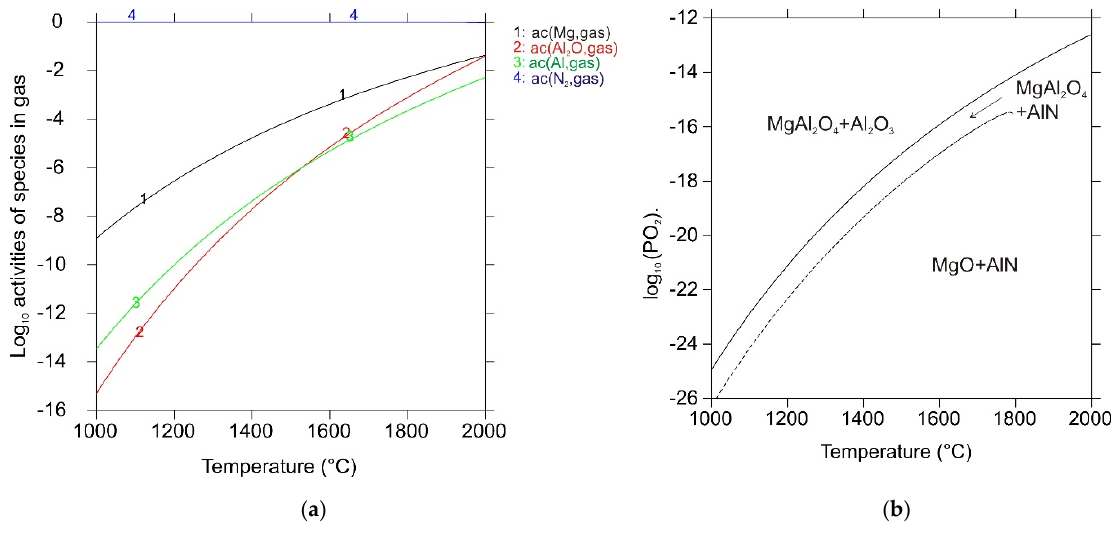
Figure 2. Equilibrium of MgAl 2 O 4 with Al 2 O 3 and AlN in the presence of gas as a function of temperature: ( a ) activities of gas species and ( b ) partial pressure of oxygen (in bar); the dashed line shows the stability limit of MgAl 2 O 4 .